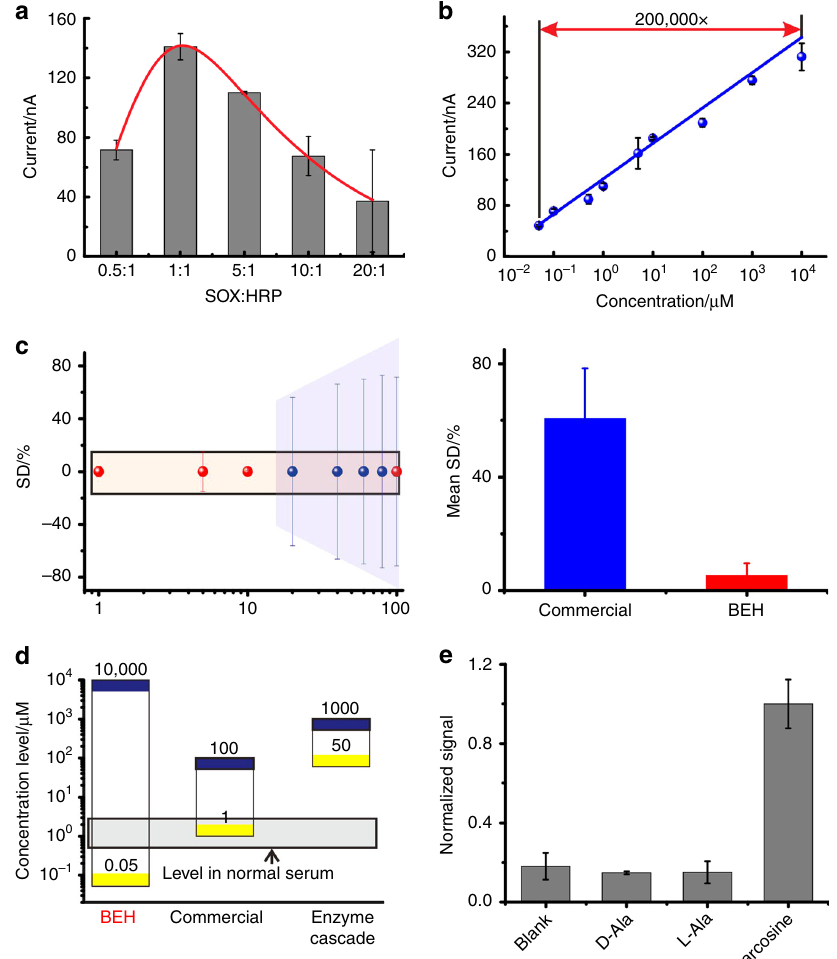
Fig. 4 The sensing performances of BEH device. a The molar ratio of SOX and HRP was optimized. b The titration curve of sarcosine detection in serum, indicating the ability to detect sarcosine in complicated samples. The dynamic range spans from 50 nM to 10 mM. c Standard variation for a series of sarcosine dilutions for BEH and commercial kit (left). Mean standard variation for sarcosine dilutions for BEH and commercial kit. d Comparison of dynamic range of BEH, commercial kit, and enzyme cascade reaction in solution. The gray area indicates the sarcosine level in serum of healthy people. e The BEH device was highly speci fi c to sarcosine. The signal from some other interferences such as the isomers of sarcosine (D-alanine and L-alanine) was similar to background signal. Error bars represent the mean ± s.d. of triplicates. Source data are provided as a Source Data fi (Fig. 5a). We collected serum samples from cancer patients (45 cases, Supplementary Dataset 3) and normal people (45 cases). By